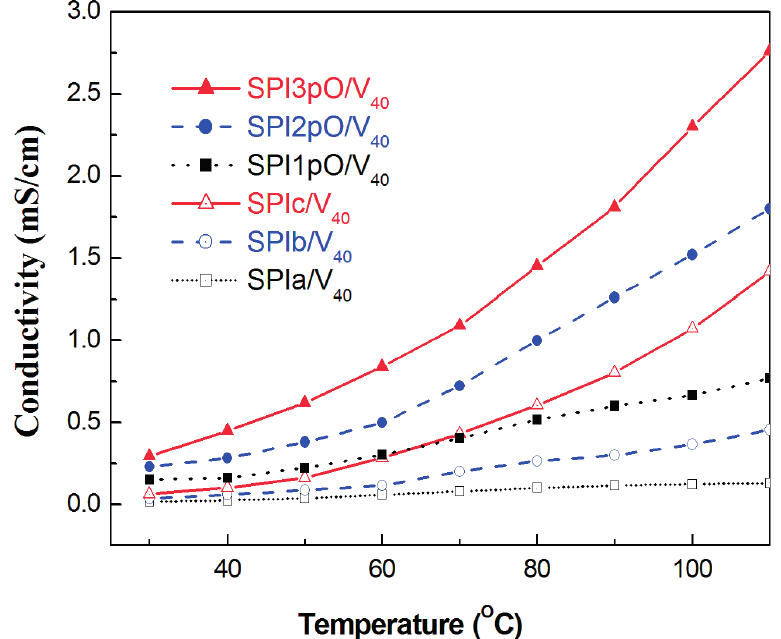
Figure 5. Temperature dependence of conductivity of SPI/PIL composite membranes prepared from different sulfonated diamines ( p BABTS vs .